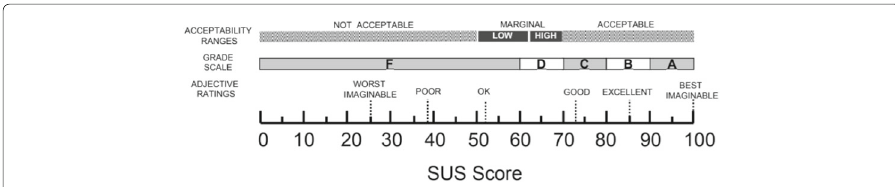
Fig. 28 A comparison of the adjective ratings, acceptability scores, and school grading scales, in relation to the average SUS score (Bangor et al.